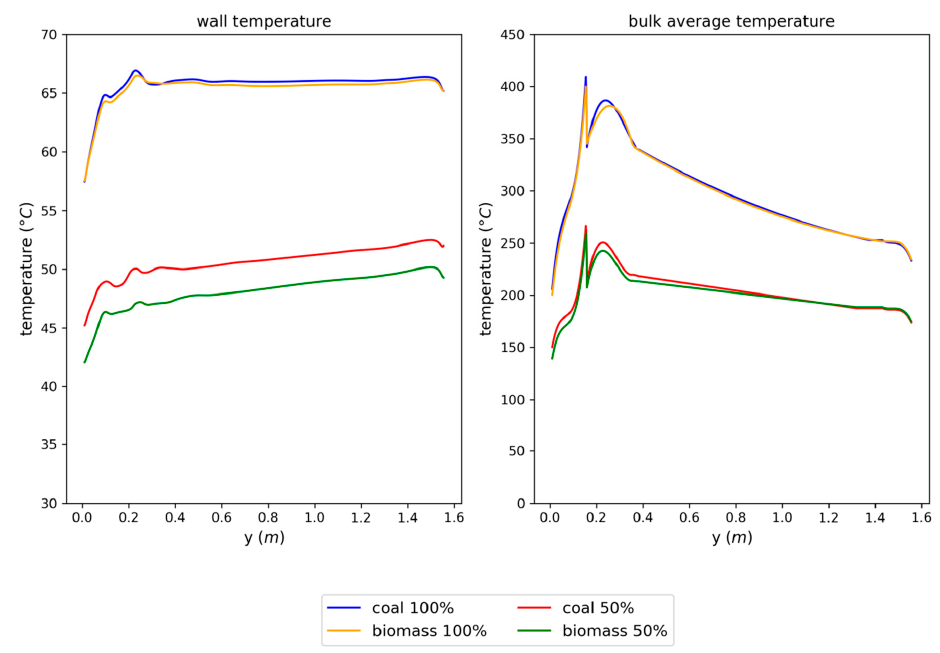
Figure 5. Distribution of exhaust gas temperature located in a layer neighboring with the combustion chamber wall and a bulk area-average temperature of flue gas as a function of chamber height.